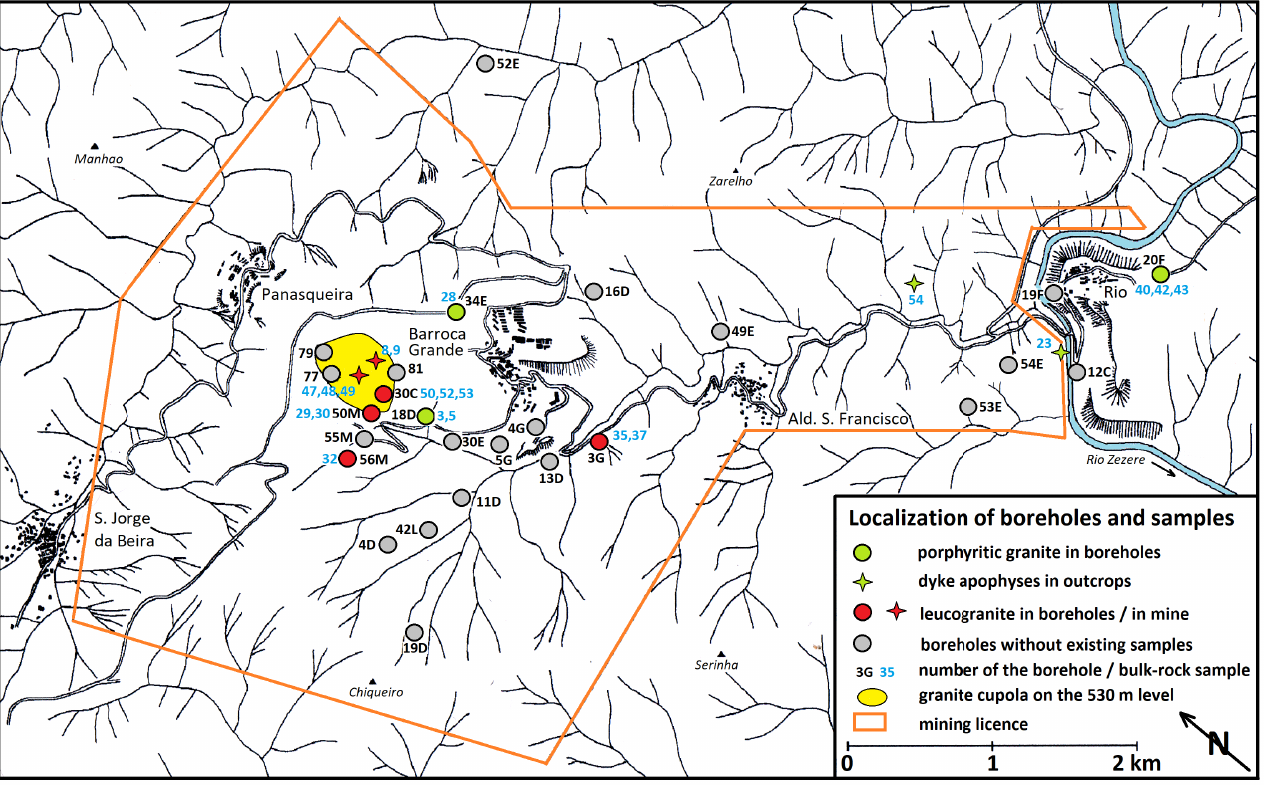
Figure 3. Locations of available borehole cores and studied bulk-rock samples. Rem.: black double line—road, black dots- buildings, black-blue double line—river Zezere, thin black